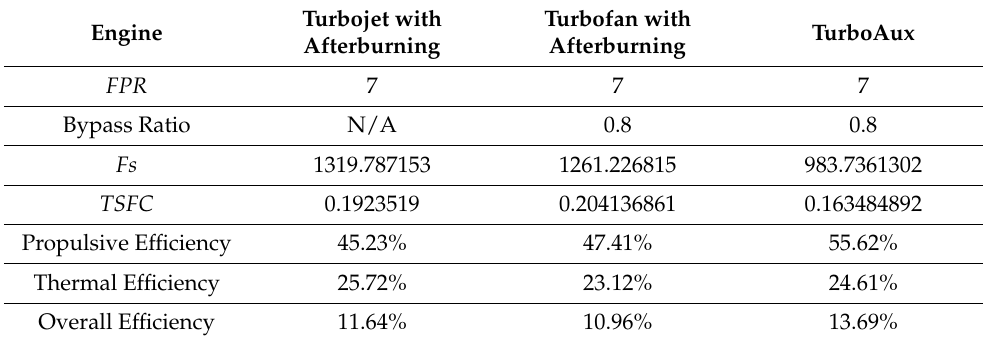
Table 7. Performance Results of Turbojet, Turbofan, and TurboAux at BPR of